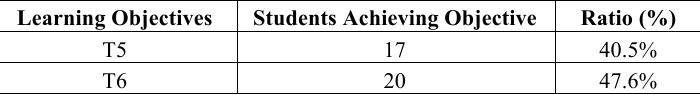
Table 5. Performance in the last two objectives of Sec. 3.1 (42